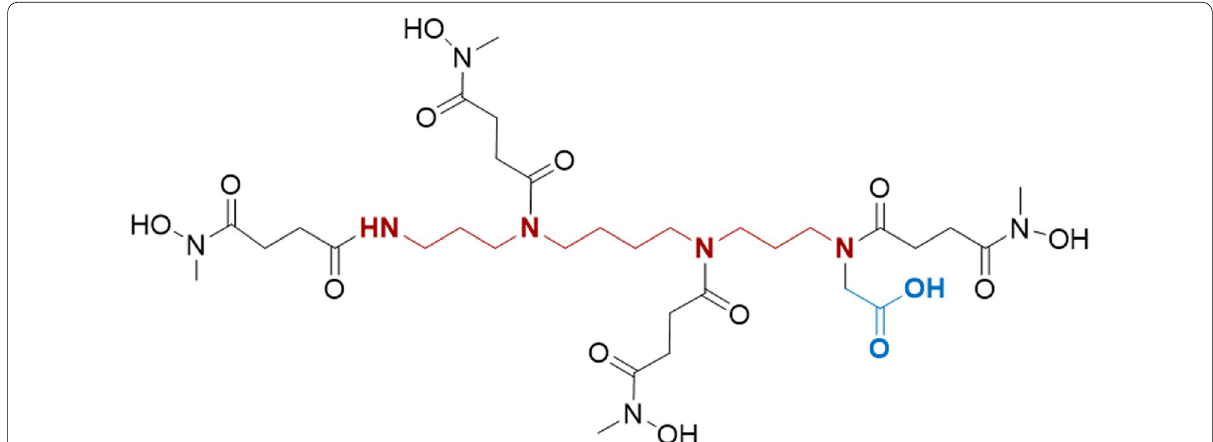
Fig. 1 Structure of the new acyclic chelator